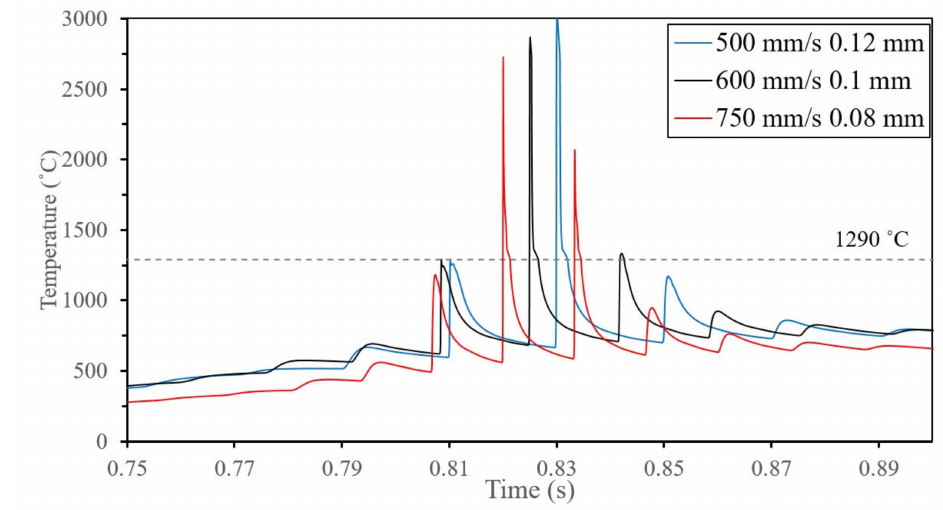
Figure 33. Temperature history at constant energy density 3.67 J/mm 2 with different scan speeds and hatch